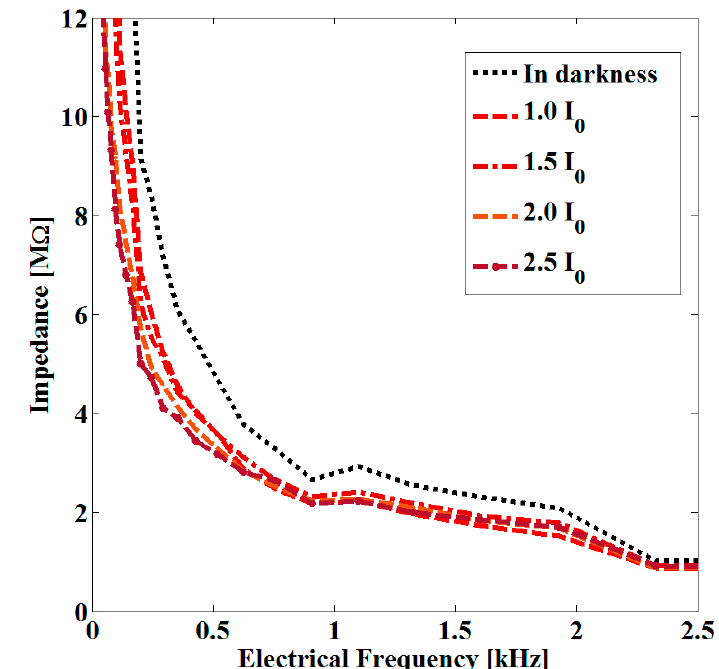
Figure 6. Impedance spectra of the studied sample before and after nanosecond pulsed irradiation at 532 nm.